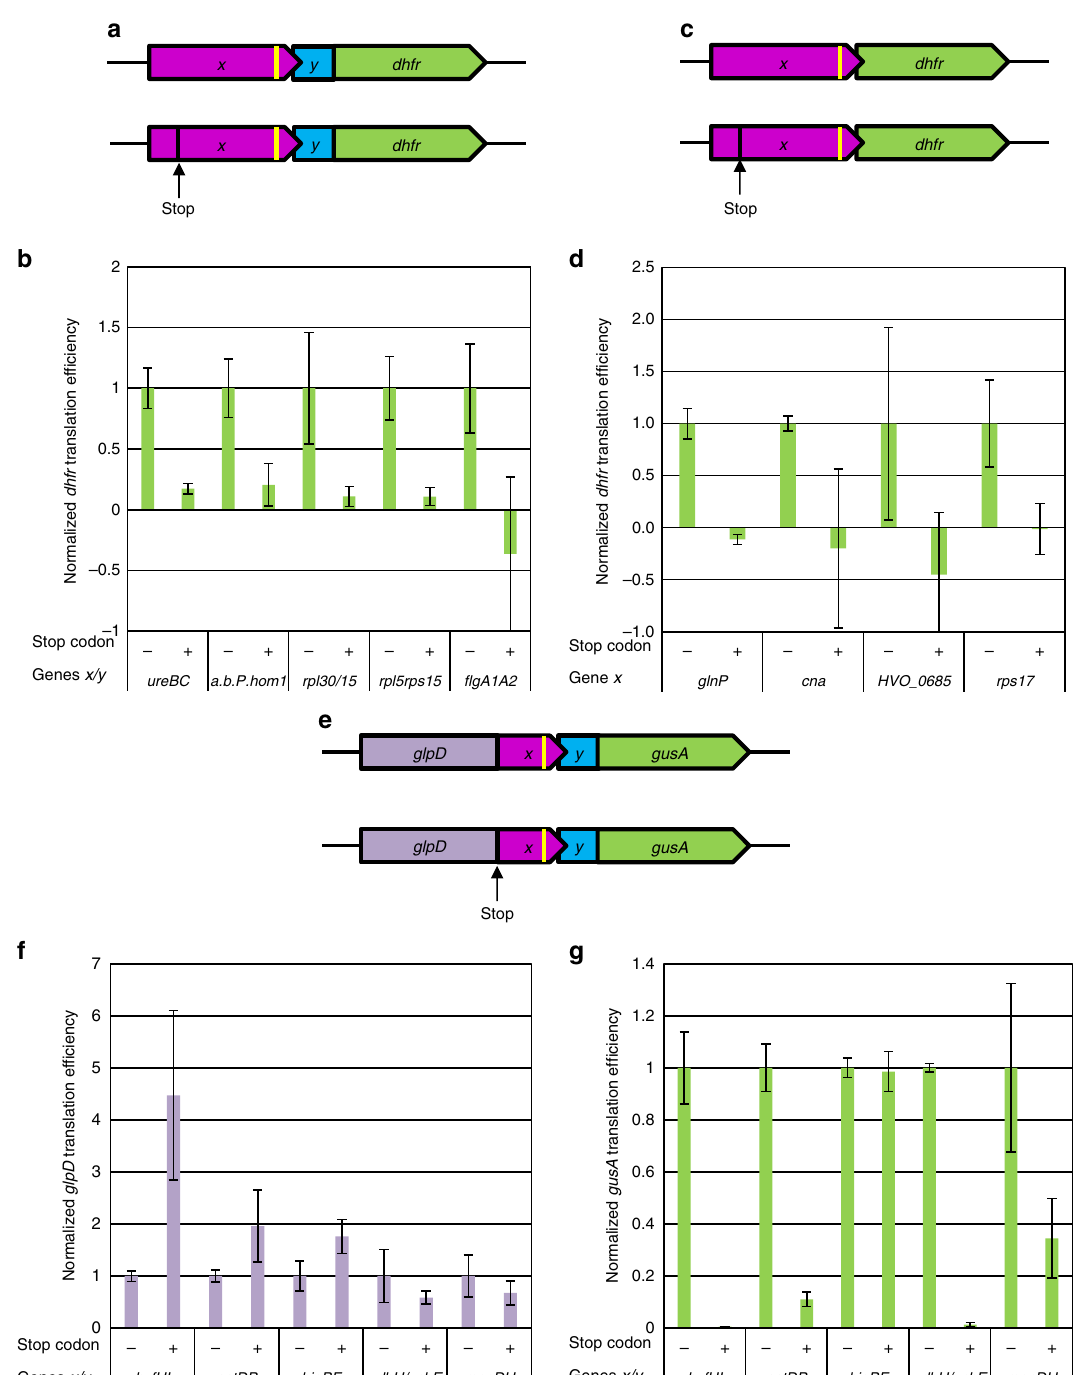
a menachinone biosynthesis enzyme. The overlapping regions of these fi ve gene pairs were cloned into a dual reporter gene vector (Fig. 4e). As a result, translational fusions were generated of the glpD reporter gene with the upstream gene and of the downstream gene with the reporter gene gusA . Also, for the E. coli gene pairs, stop codon-containing and stop codon-lacking variants were generated and compared. Initially, the entire ORFs of the gene pairs were used. However, it turned out that the stop codon-containing transcripts were strongly destabilized such that full-length bicistronic transcripts could not be detected at all, preventing quanti fi cation of translational ef fi ciencies. Therefore, the cloned regions were trimmed to the last 99 nt of the upstream